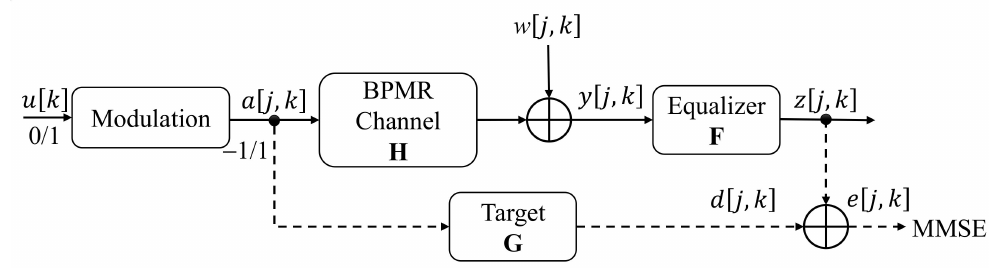
Figure 1. Training model for the GPR target and